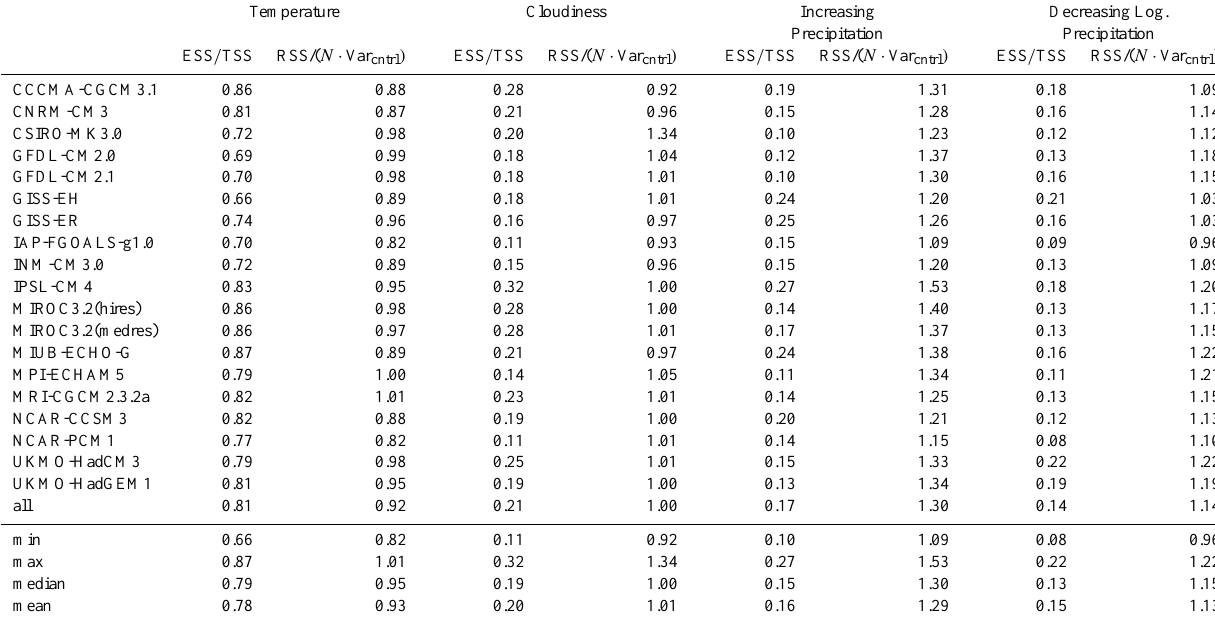
Table 2. Overview of individual AOGCMs’ ratios of explained sum squares (ESS) to total sum of squares (TSS) and ratios of residual sum of squares (RSS) to scaled control run variance ( N · Var cntrl ) for temperature, cloudiness, increasing precipitation, and decreasing logarithmic precipitation. In all cases, only significant linear regression models are included. The scaling of control run variance is necessary to make it comparable to RSS, which is calculated for N